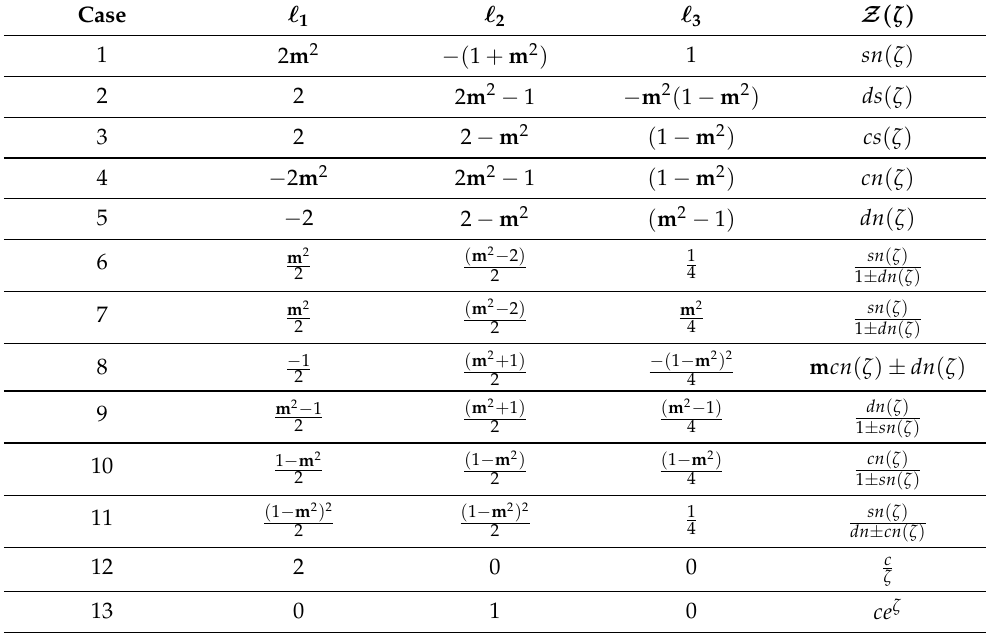
Table 1. All possible solutions for Equation (14) for different values of (cid:96) 1 , (cid:96) 2 and (cid:96) 3 .